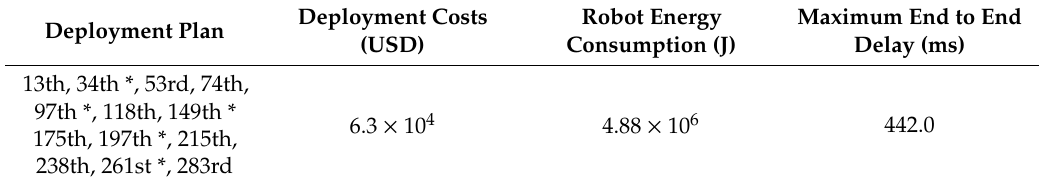
Table 8. Communication network deployment scheme of the inspection robot. Deployment